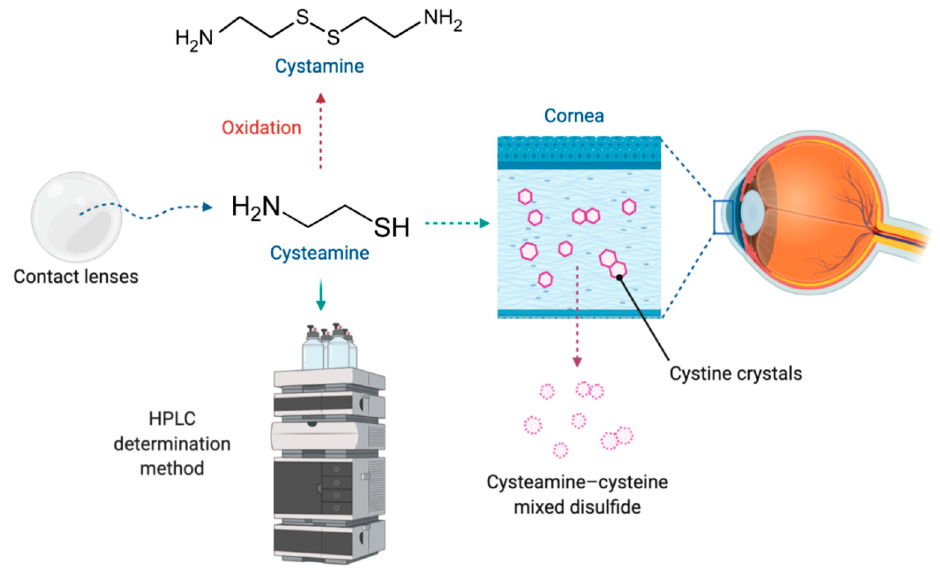
Figure 1. Cysteamine released from a drug delivery system to the ocular surface, where it forms the complex cysteamine-cysteine, facilitating the removal of cystine crystals from the cornea. Cysteamine is easily oxidized to cystamine, and can be detected from several determination methods, such as high-performance liquid chromatography (HPLC).